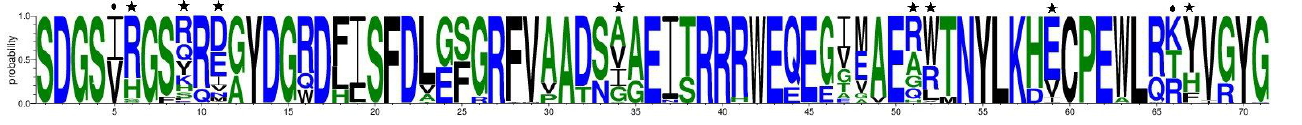
Figure 2. DAPC scatterplot of the nine MHC class I supertypes. Seven Principal components (PCs) were retained during analyses to describe the relationship between the clusters. The scatterplot shows only the first two PCs of the DAPC of MHC supertypes. The bottom right graph illustrates the variation explained by the PCs. Alleles are represented as dots and supertypes as ellipses.